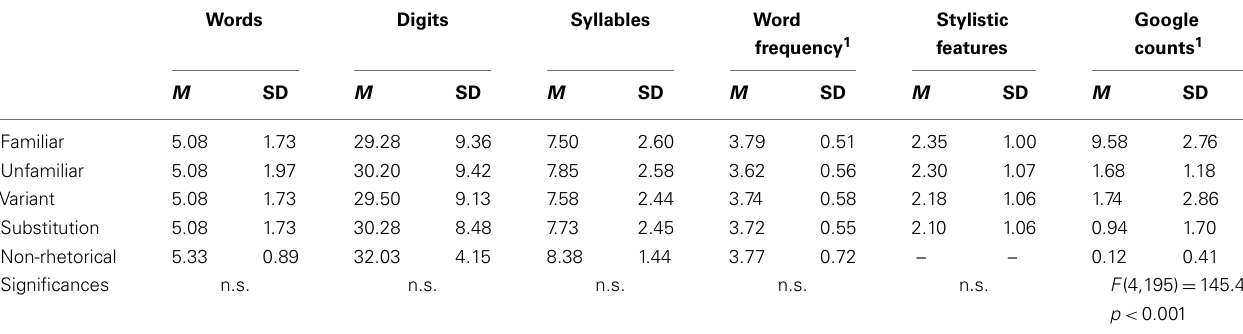
Table 2 | Formal stimulus characteristics.